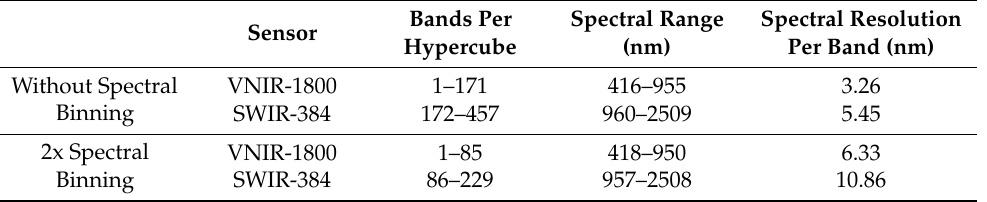
Table 1. Number of bands, spectral range, and spectral resolution before and after the binning